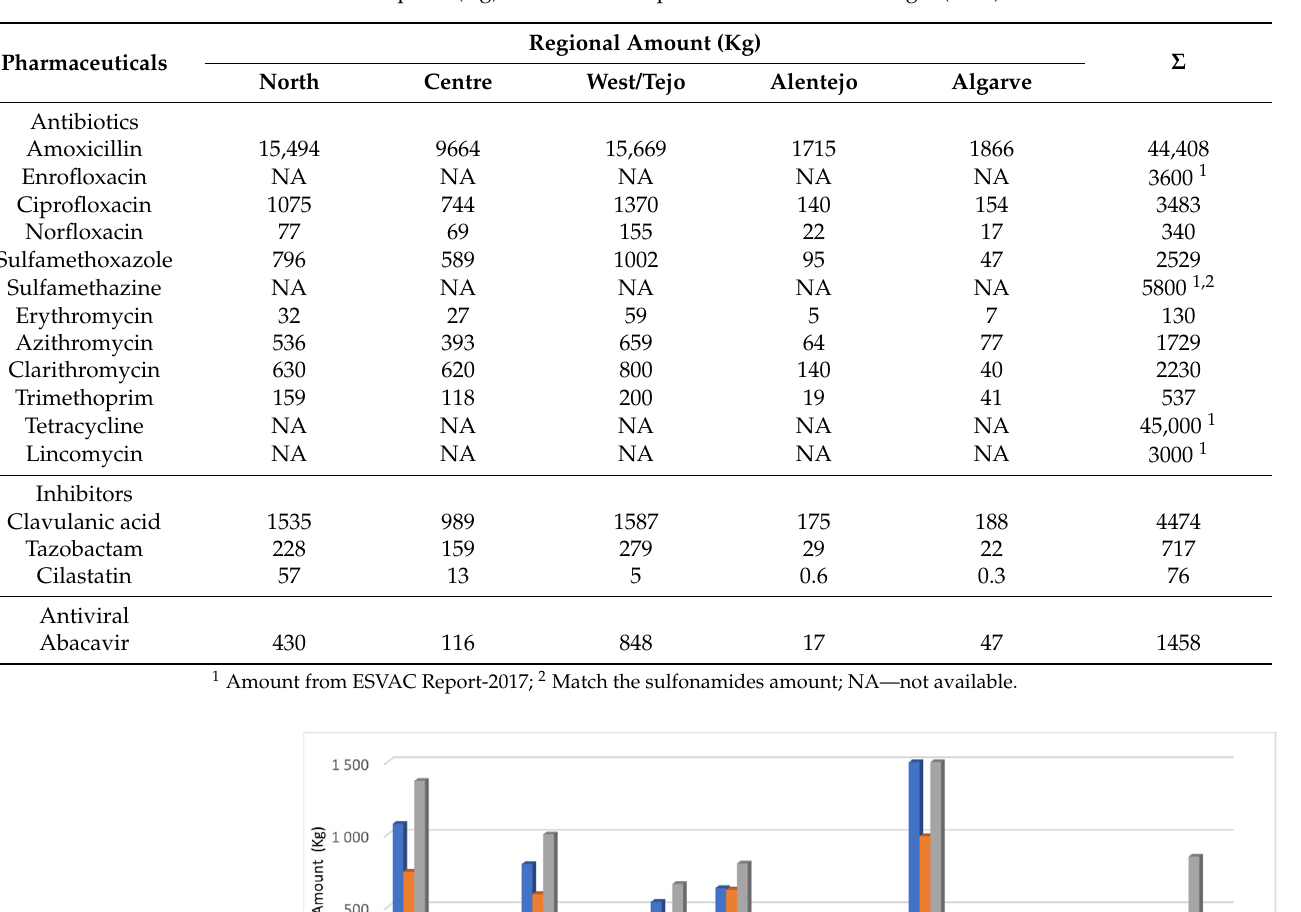
Table 1. Consumption (Kg) of the detected pharmaceuticals in Portugal (2017).